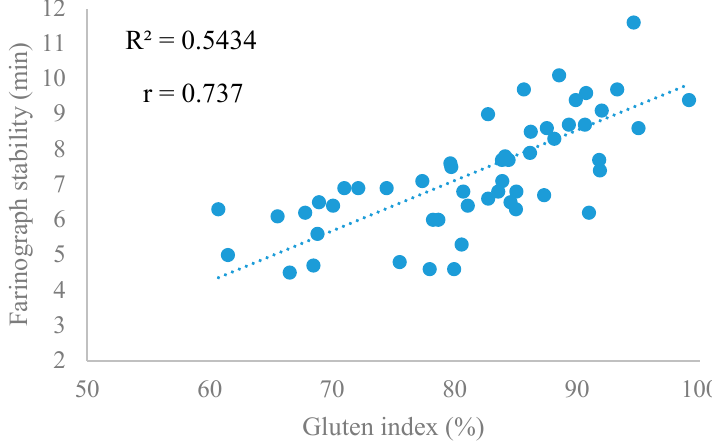
Figure 2. Correlation between gluten index and farinograph stability.